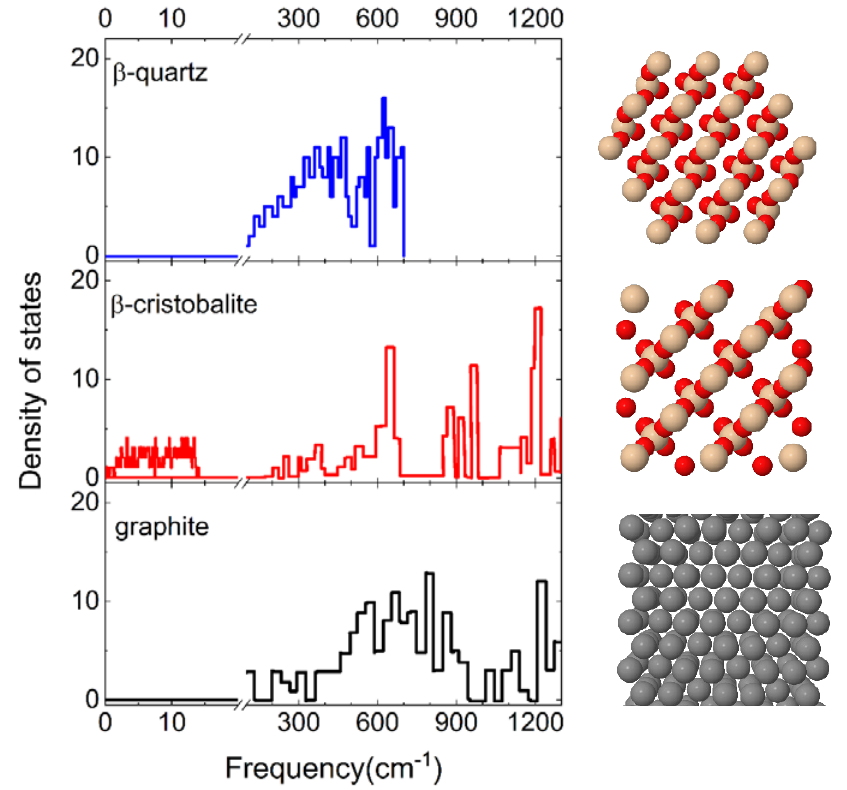
Figure 8. ( left ) Phonon frequency distributions of the β -quartz [34], β -cristobalite surfaces [35]. The distribution for the graphite surface [36] is also reported for comparison, being useful in the discussion. A break is inserted on the frequency axis between 20 cm − 1 and 100 cm − 1 . ( right ) Top view of crystal structures of the corresponding material.